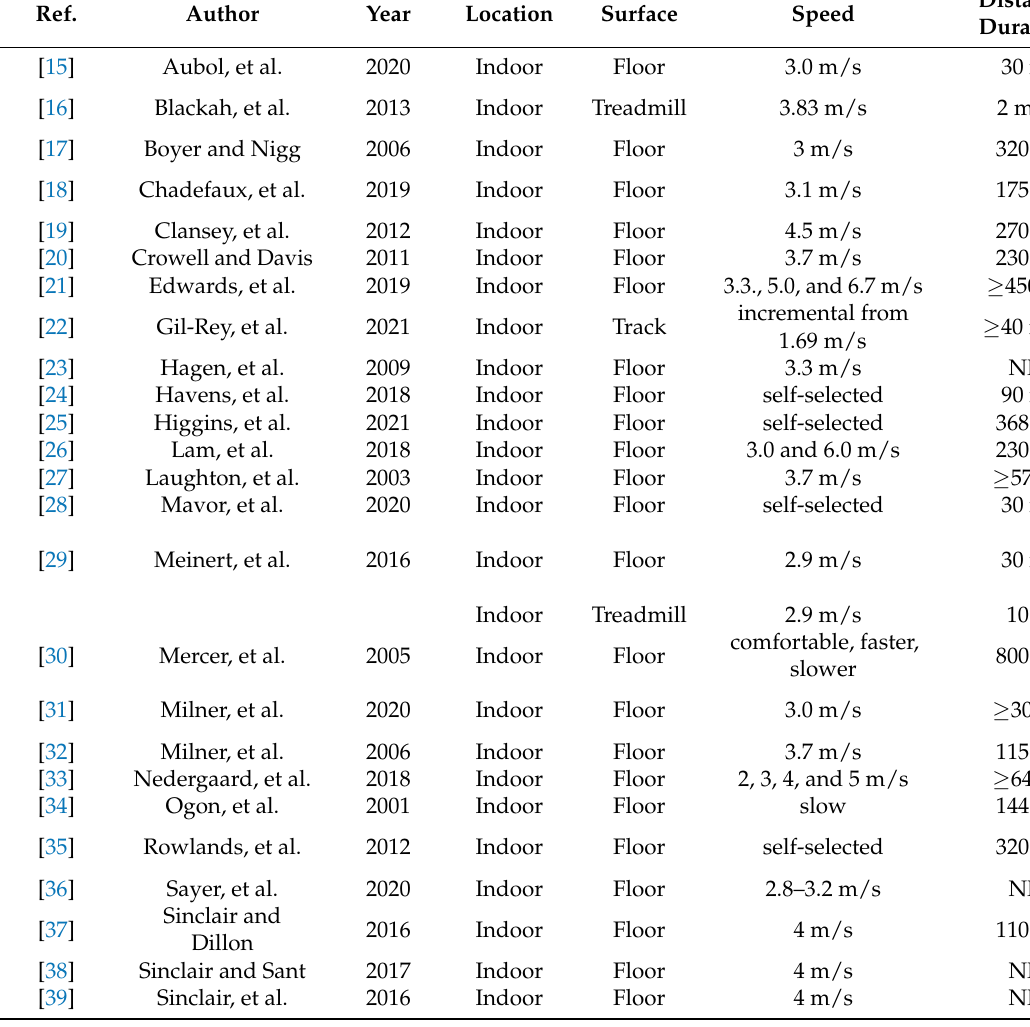
Table 1. Study characteristics where the analyzed distance is one step/stride.